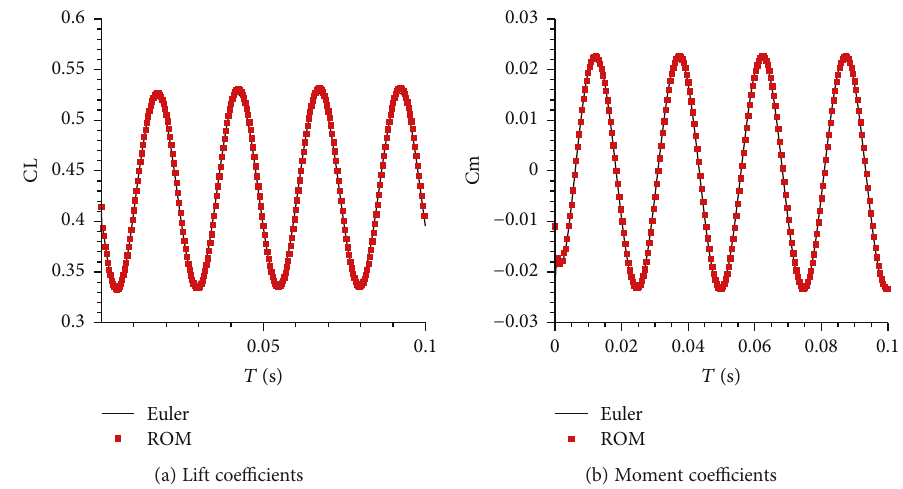
Figure 9: Comparison of the aerodynamic coe ffi cients obtained from Euler and ROM when f = 40